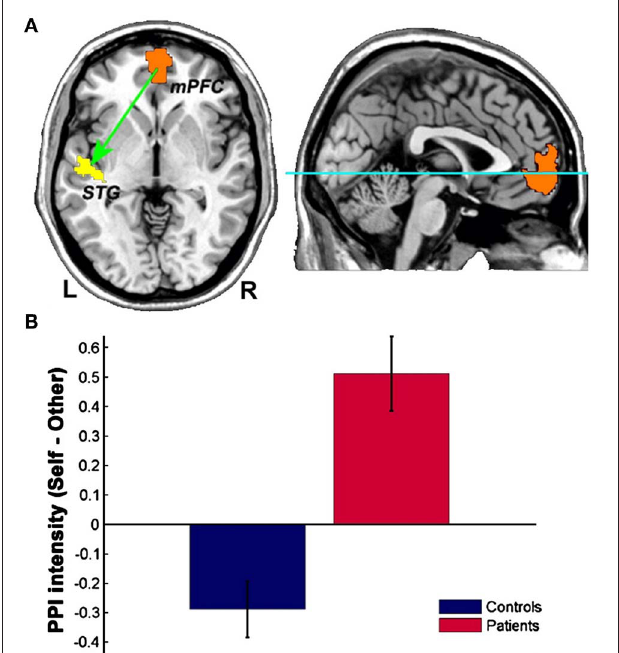
FIGURE 2 | Changes in functional connectivity with the medial prefrontal cortex in schizophrenia. The psychophysiological interaction (PPI) analysis revealed that functional connectivity from the medial prefrontal cortex to the left superior temporal gyrus is significantly modulated by source memory condition (A) By averaging the PPI intensity over the voxels within the significant cluster for each subject, a significant interaction effect was found: higher connectivity is observed in the Self condition in patients with schizophrenia, whereas healthy subjects display higher connectivity in the Other condition (B) Reprinted from Wang et al. (2011). Aberrant connectivity during self-other source monitoring in schizophrenia. Schizophr. Res . 125, 136–142 with permission from